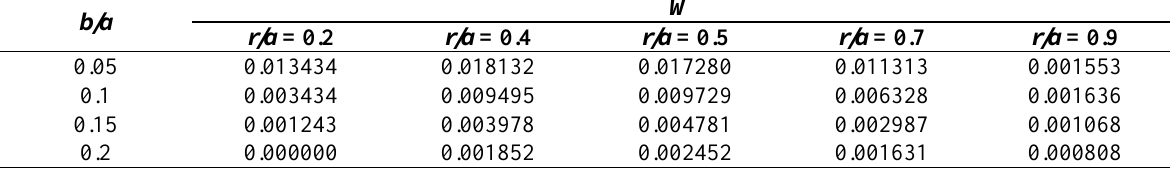
Table 4. Deflection at several points of the plate with ratio b/a ranging from 0.05 to 0.2